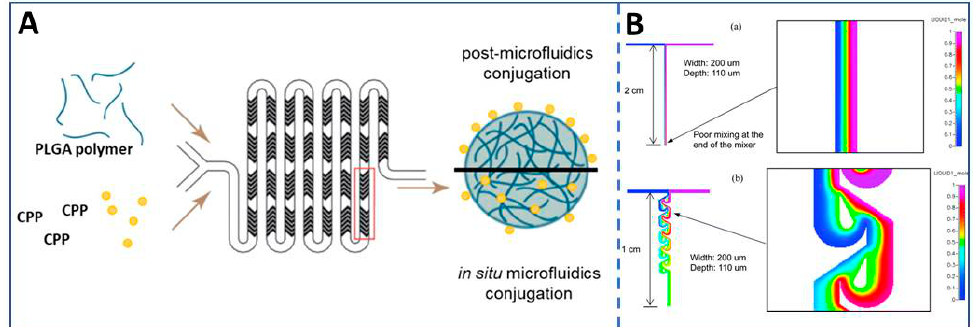
Figure 3. Two typical structures for mixing adequately in a microfluidic system. ( A ) A microfluidic system utilized herringbone structures to complete a zero-length crosslinking reaction for the covalent attachment of cell-penetrating peptides (CPPs) to poly(lactic-co-glycolic) acid (PLGA) nanoparticles, reproduced with permission from [75]. ( B ) Comparing the mixing e ffi ciency of the T-type and the Tesla structure, the Tesla structure mixes the two fluids highly-e ffi ciently through a 1 cm length of the perpendicular channel, relative to the T-type channel that shows a weak mixing e ffi ciency, even though it flows through a 2 cm perpendicular channel, reproduced with permission from [72].